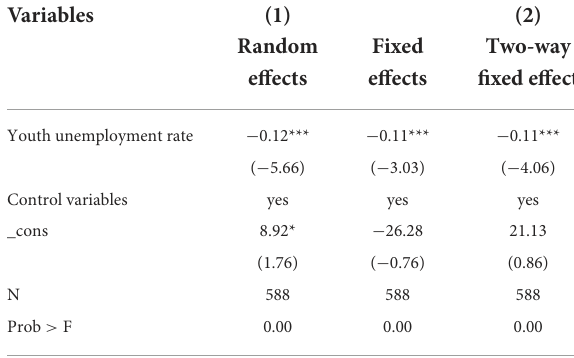
TABLE 4 Robustness tests: Replacing core explanatory